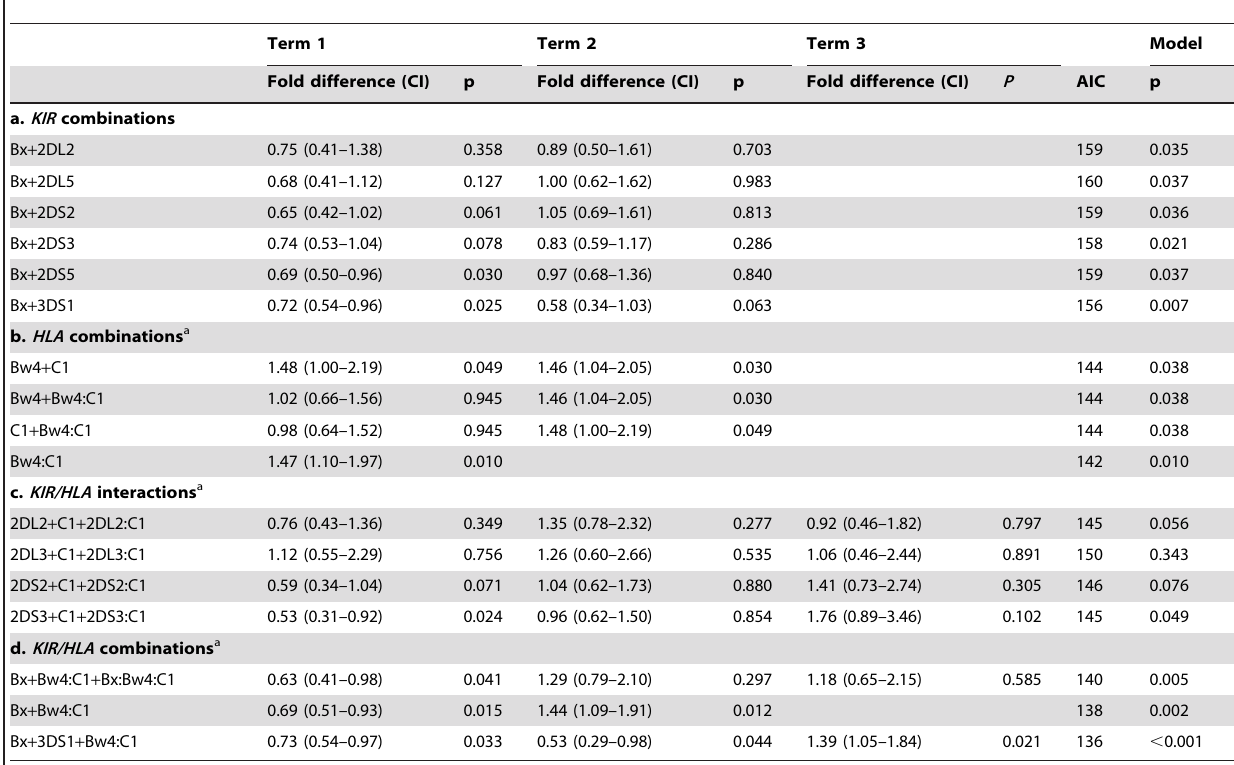
Table 2. Multivariate effects of KIR and HLA genes on the CD4 + T cell count of 81 HIV-1 infected subjects.